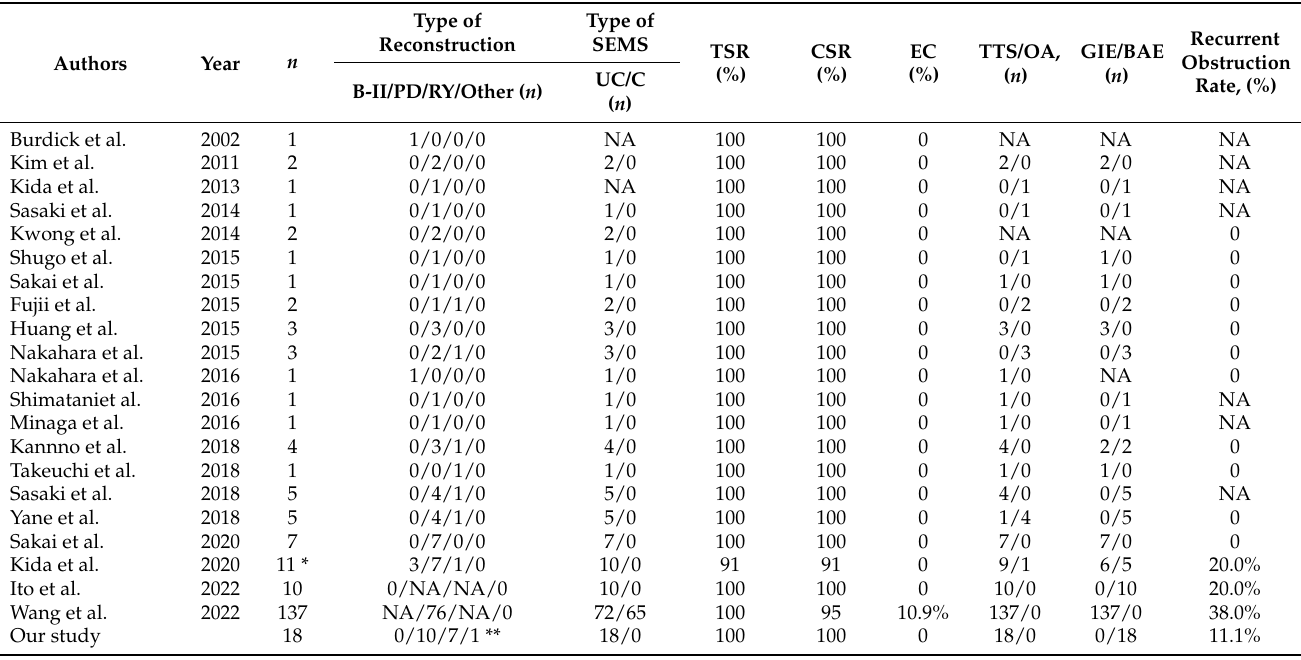
Table 4. Previous reports of endoscopic transluminal self-expandable metal stent placement for malignant afferent loop